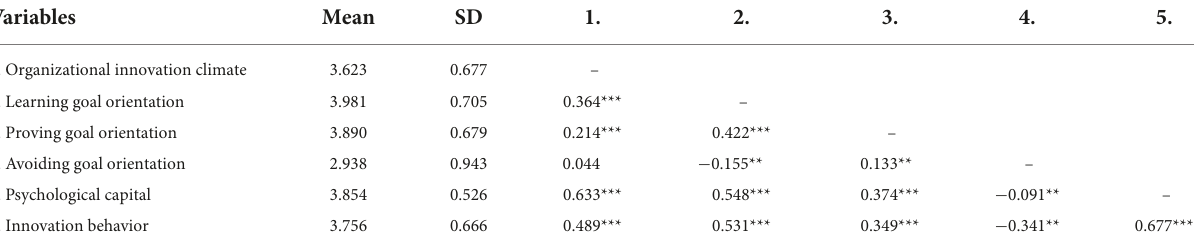
TABLE 3 Means, standard deviations, and correlations ( n =